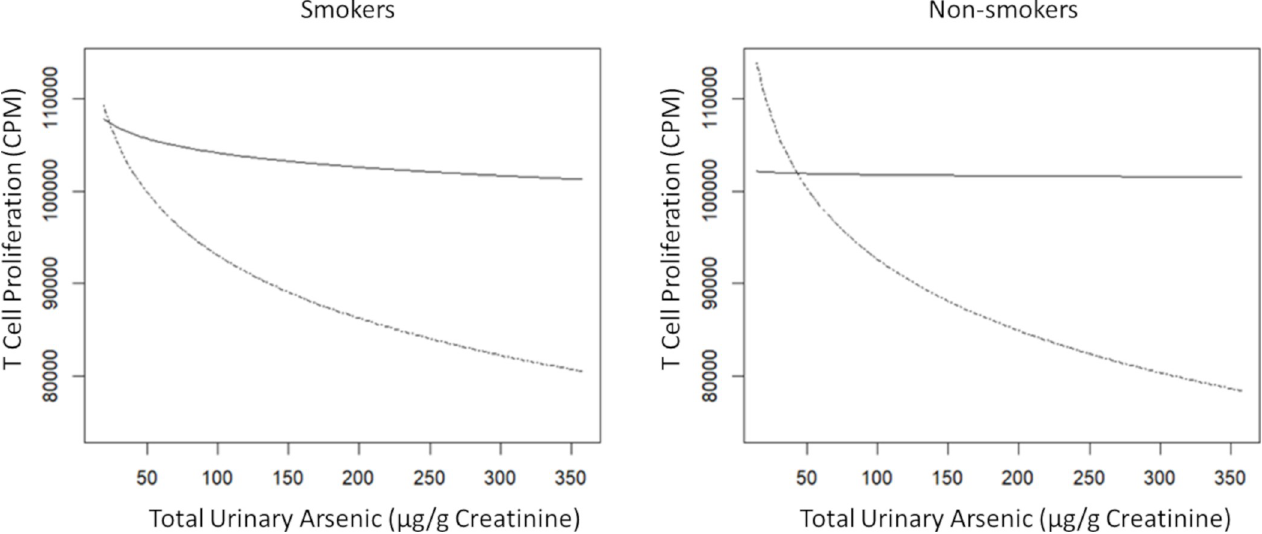
Fig 1. Age and BMI adjusted association of urinary arsenic with T cell proliferation (TCP) in male smokers and non-smokers with sufficient or deficient serum VitD levels. Male Smoker (n = 173) and Male Non-smoker (n = 61) by High/sufficient VitD serum concentration ( > 20 ng/ml), indicated by black solid line, and low/deficient serum VitD ( < 20 ng/ml) by broken line. Approximately 20% of male smokers and non-smokers in both groups were found to be VitD–